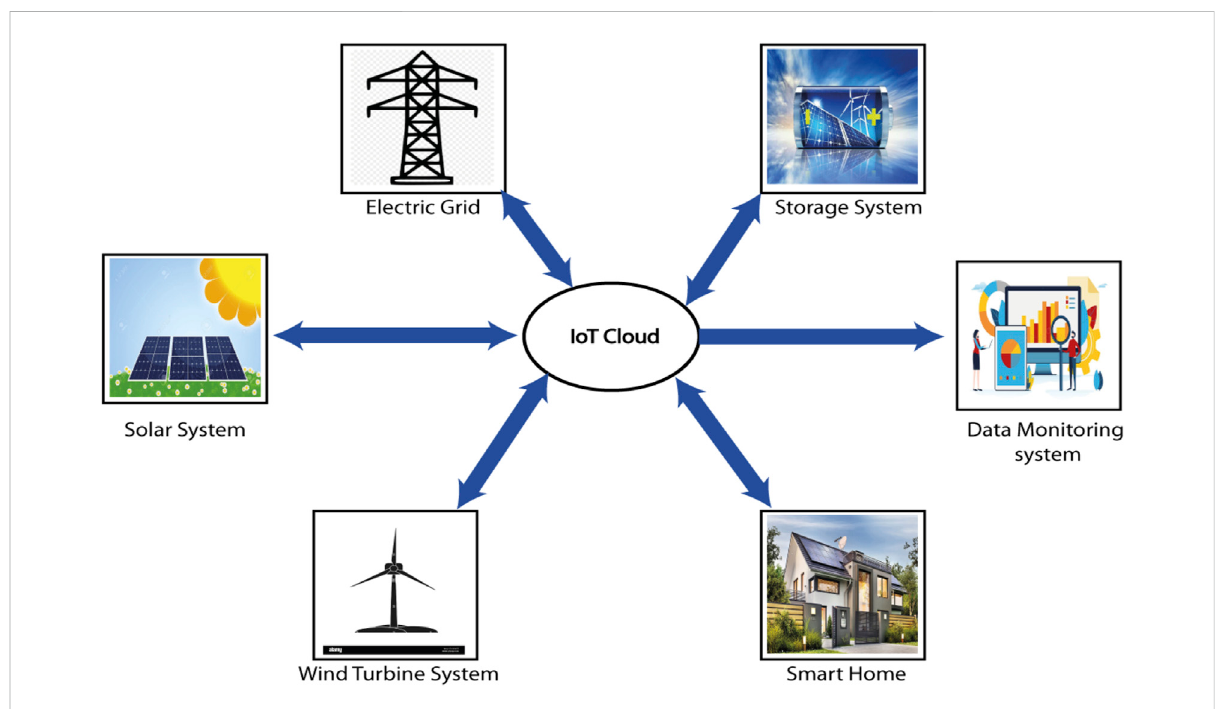
FIGURE 8 Microgrid monitoring using Cloud